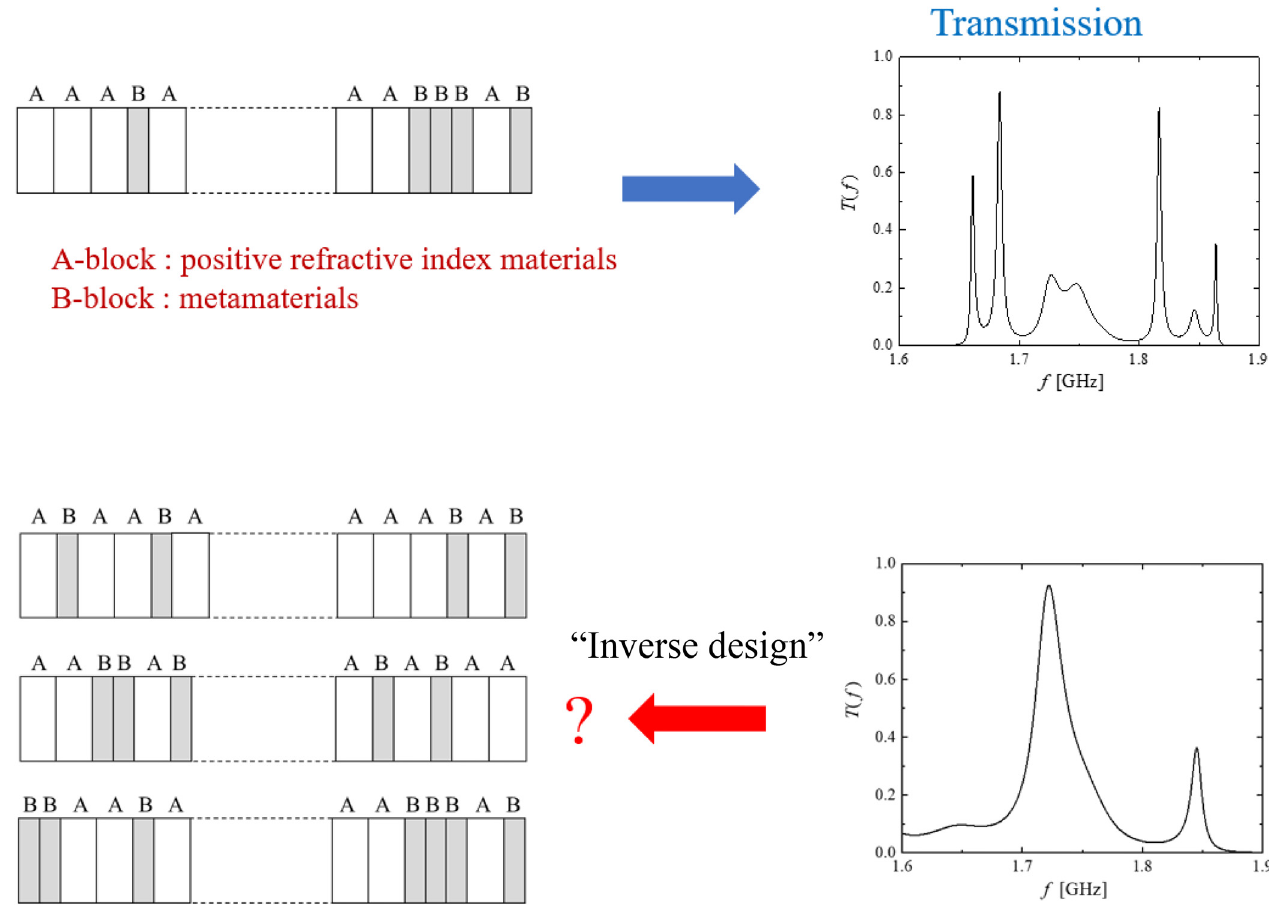
Fig. 5. Optimized design of metamaterial multilayers.